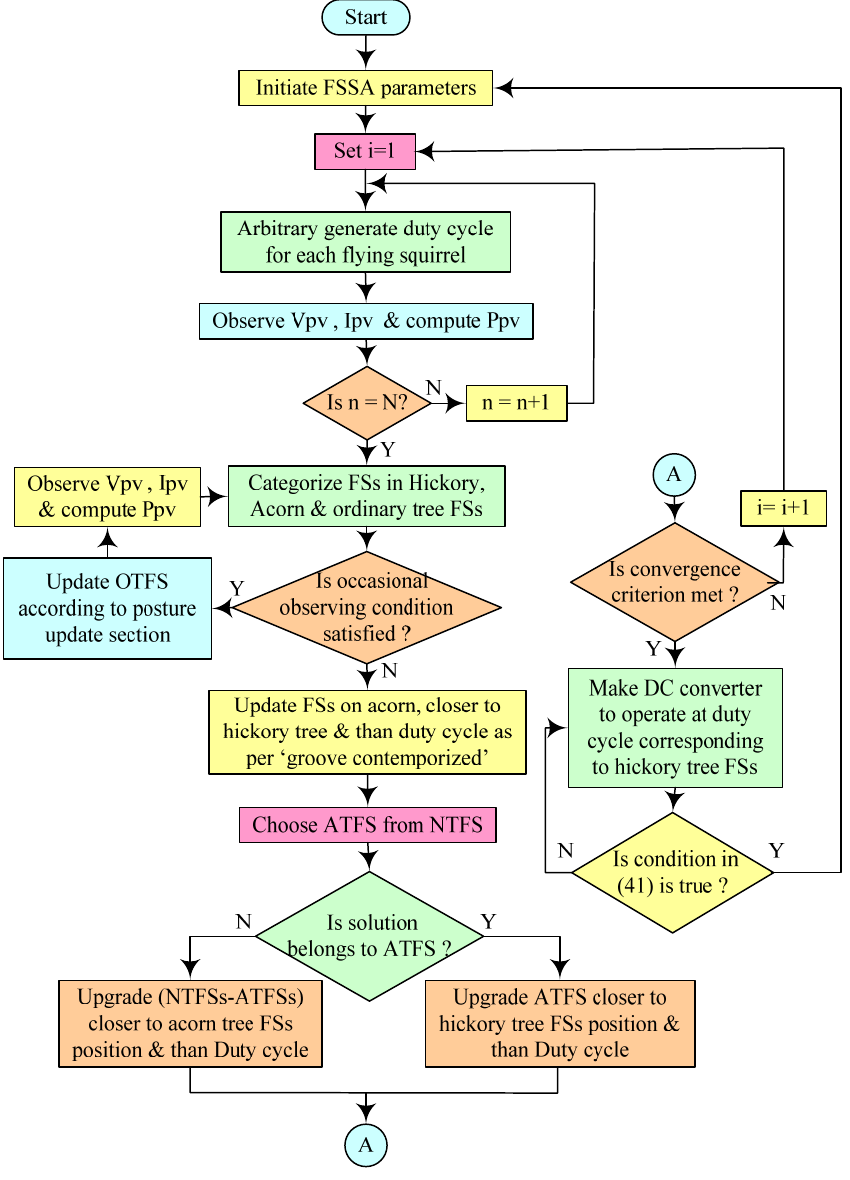
Figure 20. FSSO-based MPPT technique [89].